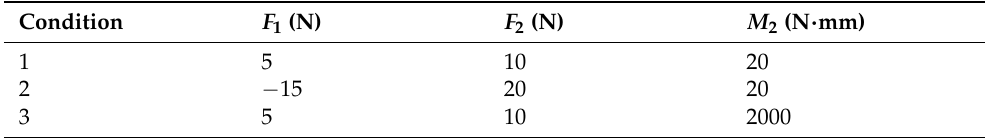
Table 2. Working cases for the method